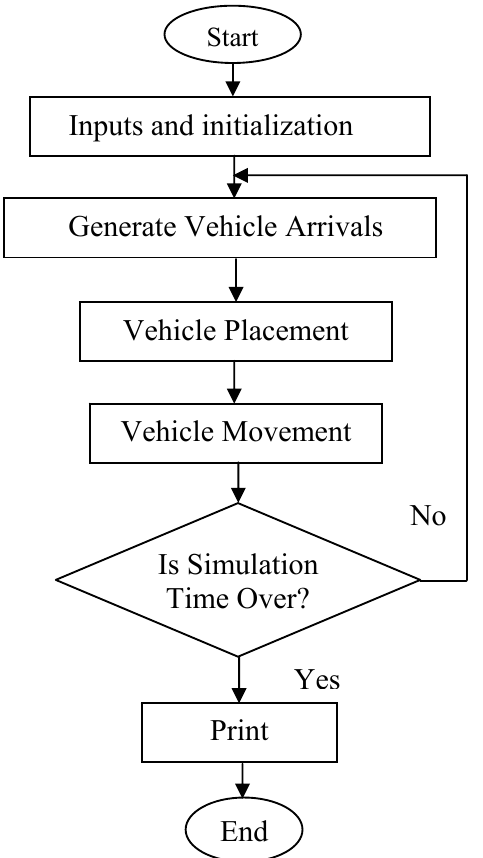
Figure 1. Flow diagram of the simulation